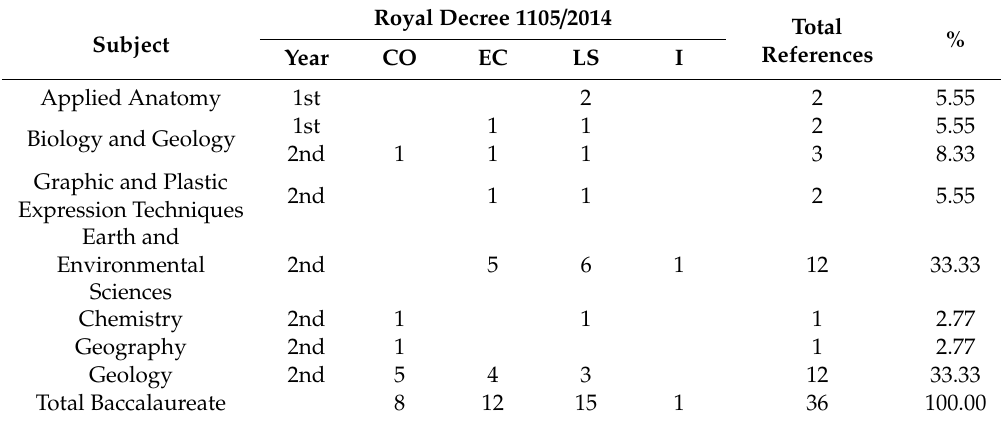
Table 3. Number of occasions in which the concept of water appears and percentage in the di ff erent subjects in the baccalaureate curriculum. Abbreviations: Contents (C), Evaluation Criteria (EC), Learning Standards (LS) and Introduction